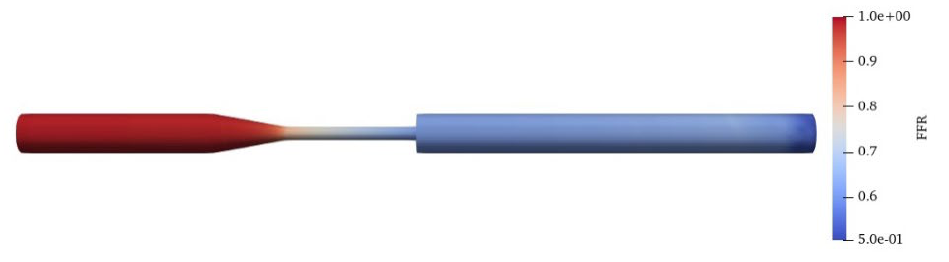
Figure 22. FFR distribution and shape of FDA nozzle model. Residual values for the steady-state and transient simulations are shown in Figures 23 and 24, respectively. Based on the appropriate convergence of the residual values, the findings could be considered acceptable.